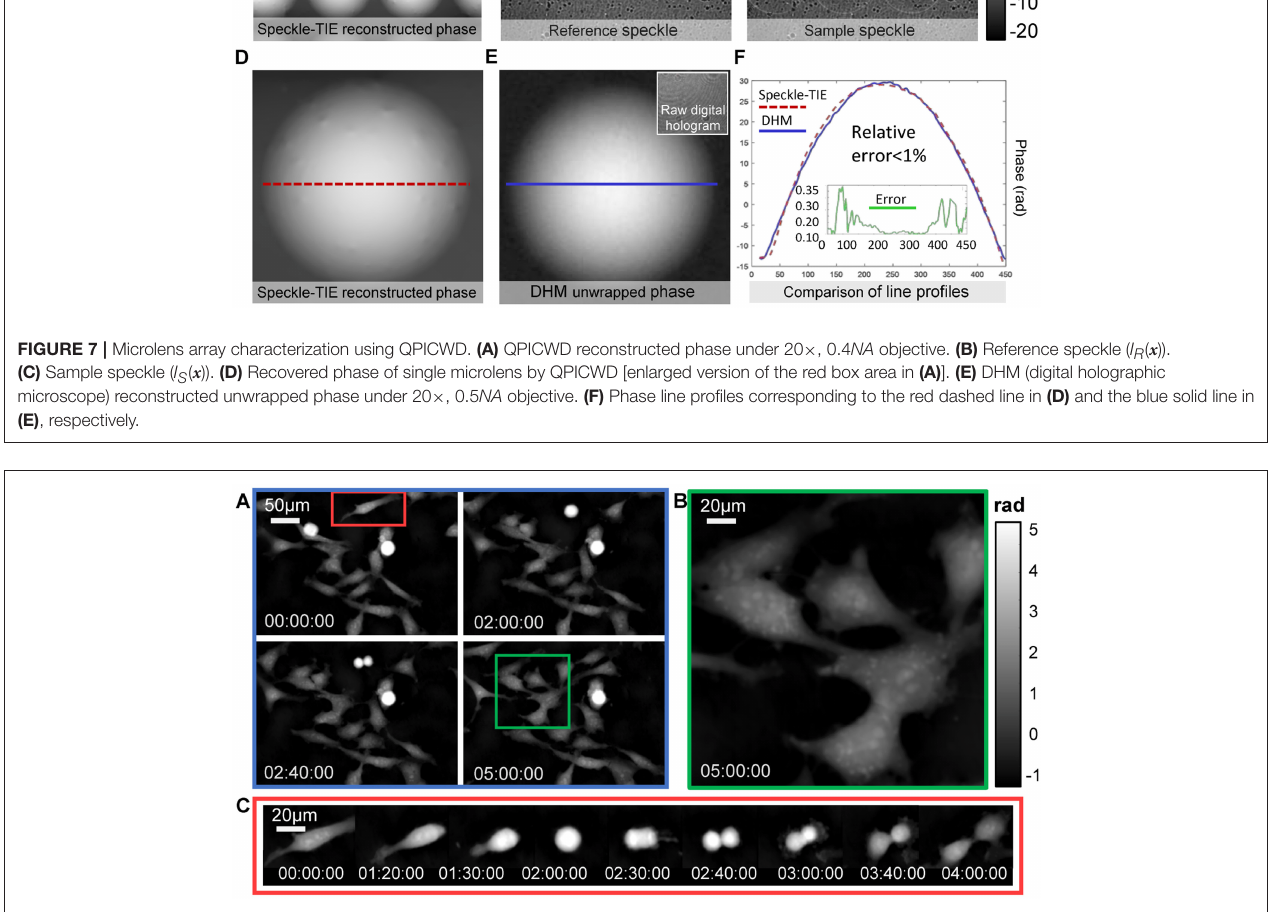
FIGURE 8 | Time-lapse phase imaging of HeLa cell division over a long period (5 h). (A) Representative quantitative phase images. (B) The magnified view corresponding to the region of interest [the green box in (A) ]. (C) 9 selected time-lapse phase images showing the morphological features of a dividing cell [the red box in (A) ] at different stages of